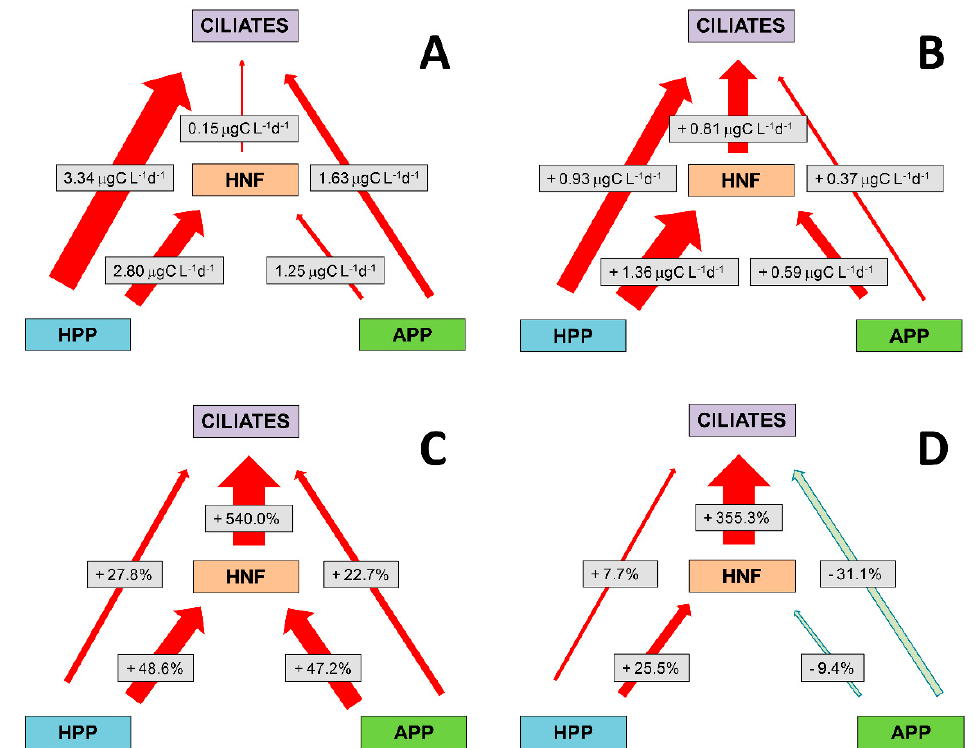
Figure 7. Absolute carbon biomass flow within the microbial food web at ambient temperature ( A ) and changes in flows after a 3 ◦ C rise in temperature, expressed in three di ff erent ways: absolute changes in the amount of consumed carbon biomass ( B ); (ii) relative changes in the amount of consumed biomass ( C ); and relative changes in biomass grazing expressed as a percentage of prey production ( D ). Arrow thickness represents the relative importance of a particular carbon